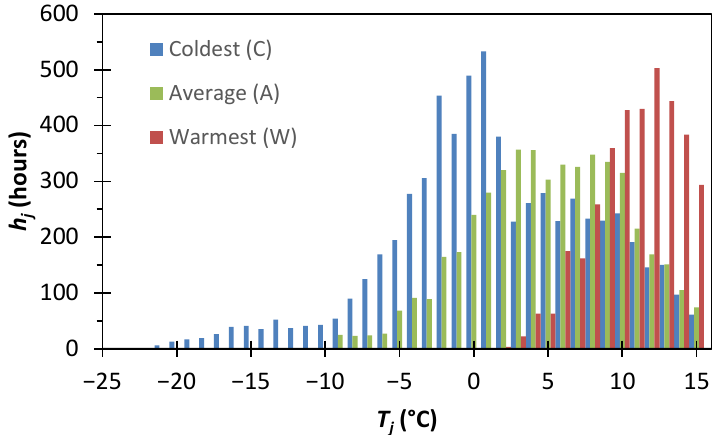
Figure 3. Distribution of outside temperatures for the climate conditions ‘A’, ‘C’, and ‘W’. To determine the SCOP of a heat pump in accordance with EN 14825, first the heating demand curve must be determined as a function of the outdoor temperature. The part load factor ( pl ) is the ratio between the heating load at a specific temperature T j and the design heating load at the design temperature T design : 𝑝𝑙(𝑇 𝑗 ) = 𝑄̇ 𝑏 (𝑇 𝑗 ) 𝑄̇ 𝑑𝑒𝑠𝑖𝑔𝑛 ⁄